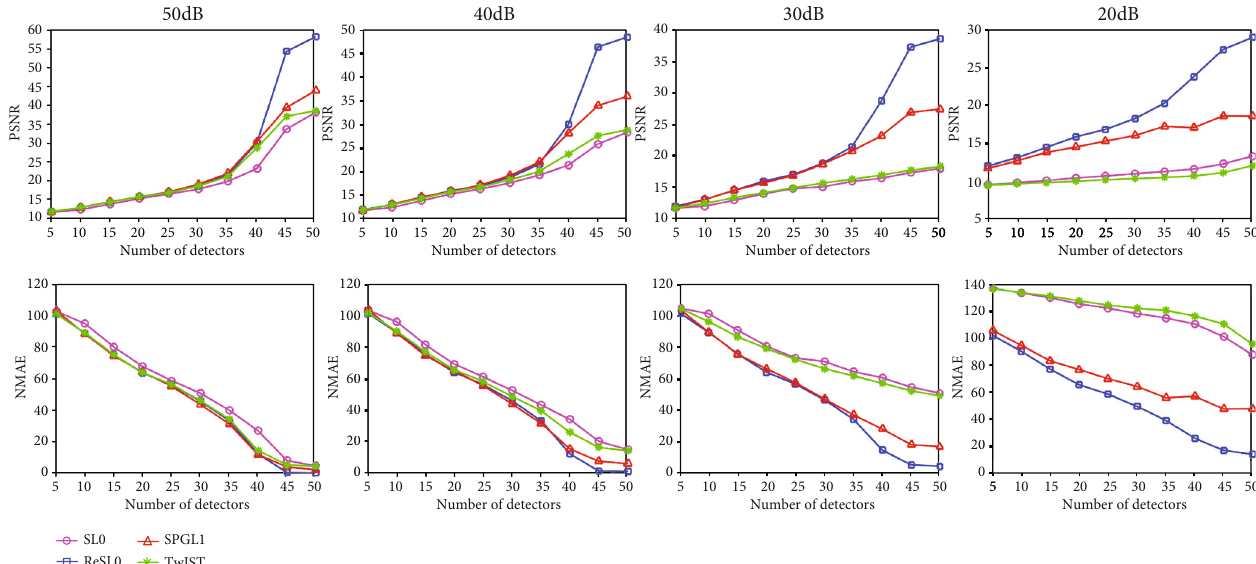
Figure 5: The PSNRs and NMAEs of reconstruction results of the Sheep-Logan phantom with di ff erent number of sampling points. (a – d) The quantitative results of noisy observation with SNR = 50 , 40, 30, and 20 dB, respectively.